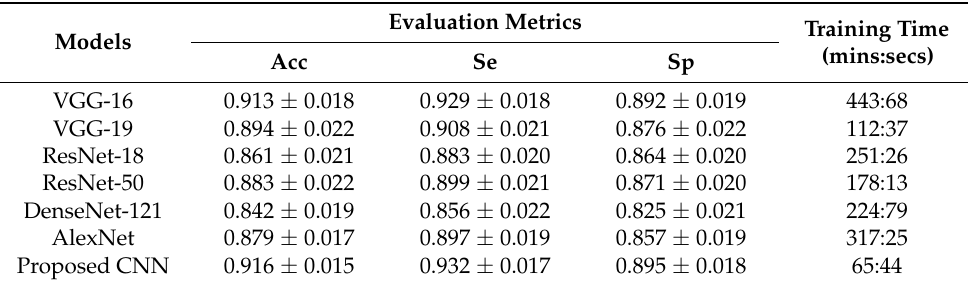
Table 7. The results of different models on the testing set in the RS dataset during the 10-fold cross-validation (mean ± standard deviation).